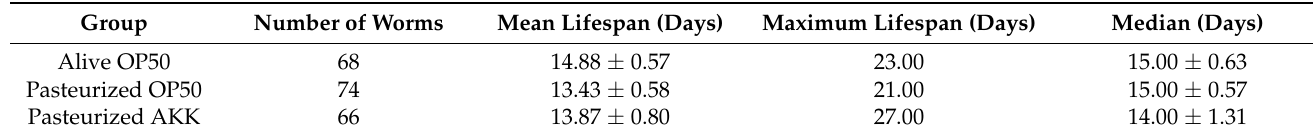
Figure 1. Positive effect of p-AKK on nematodes’ healthy lifespan. ( A ) Analysis of lifespan of nematodes fed with different bacteria. N = 3; ( B ) Analysis of normal locomotion frequency with increasing age of nematodes fed with different bacteria. There were 10 worms in each group and the experiments were independently repeated three times; ( C ) Analysis of changes in movement state with increasing age of nematodes fed with different bacteria. The results are expressed as the mean ± SD and p -values were calculated by Duncan’s tests. Significant differences between groups are expressed by different letters (a,b) within the same day ( p < 0.05). N = 3. Table 1. Lifespans of nematodes treated with different types of